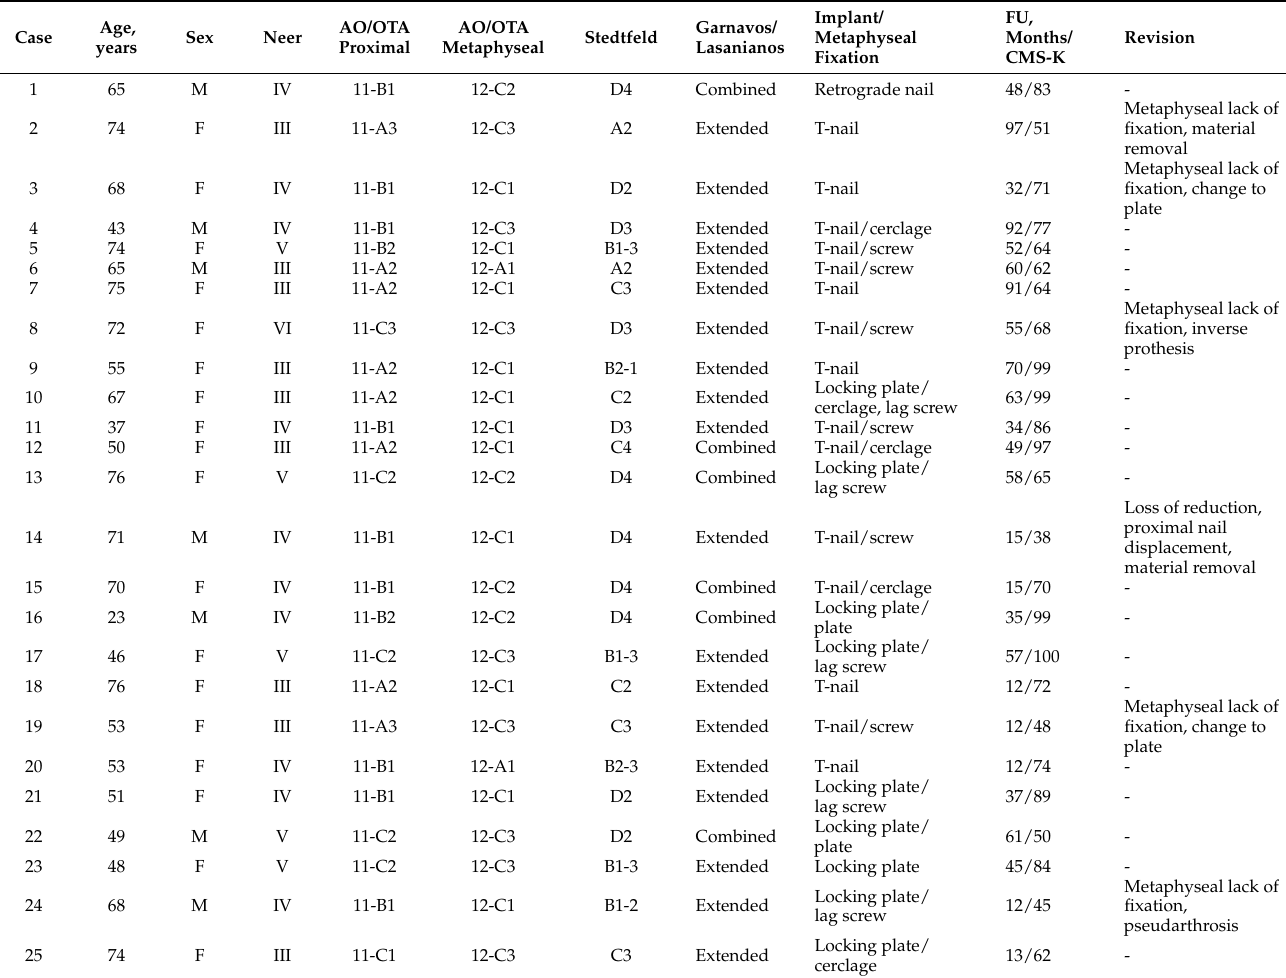
Table 1. Patient characteristics; fracture classifications according to Neer, AO/OTA proximal and metaphyseal, Stedtfeld, and Garnavos/Lasanianos; used implants; follow-up with outcome; and observed